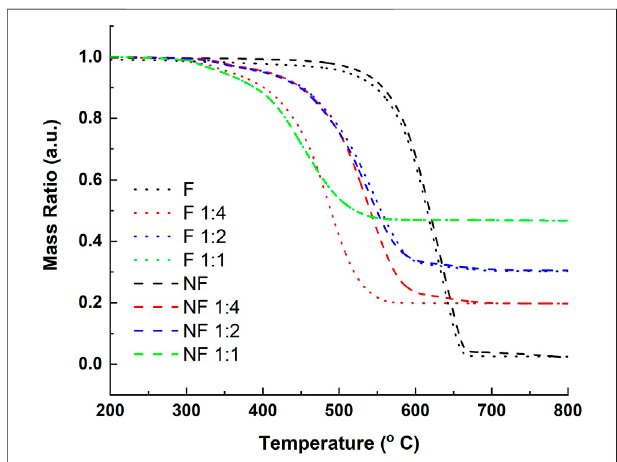
FIGURE 2 | Thermogravimetric analysis of functionalized (F) and pristine (non-functionalized -NF) CNT samples with varying silver-to-CNT mass